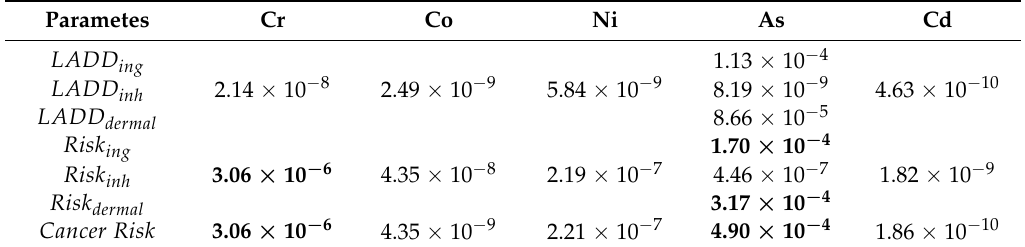
Table 8. Daily exposure dose and cancer risk of metal(loid)s in street dust to population in Hezhang city.